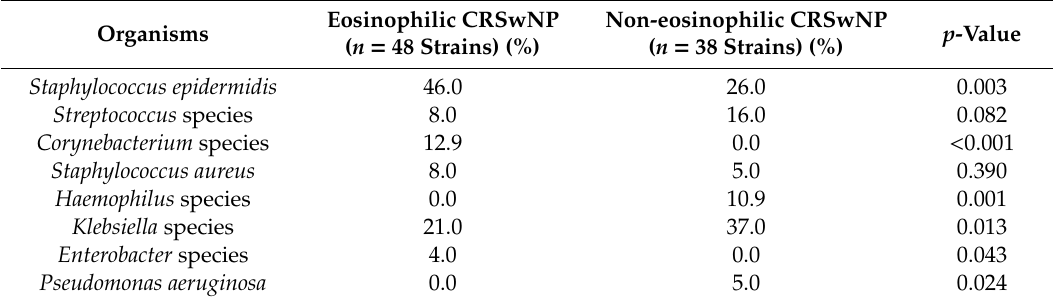
Table 4. Comparison of the isolated bacteria in patients with non-eosinophilic and eosinophilic chronic rhinosinusitis with nasal polyps (CRSwNP) between October 2017 and December 2018.